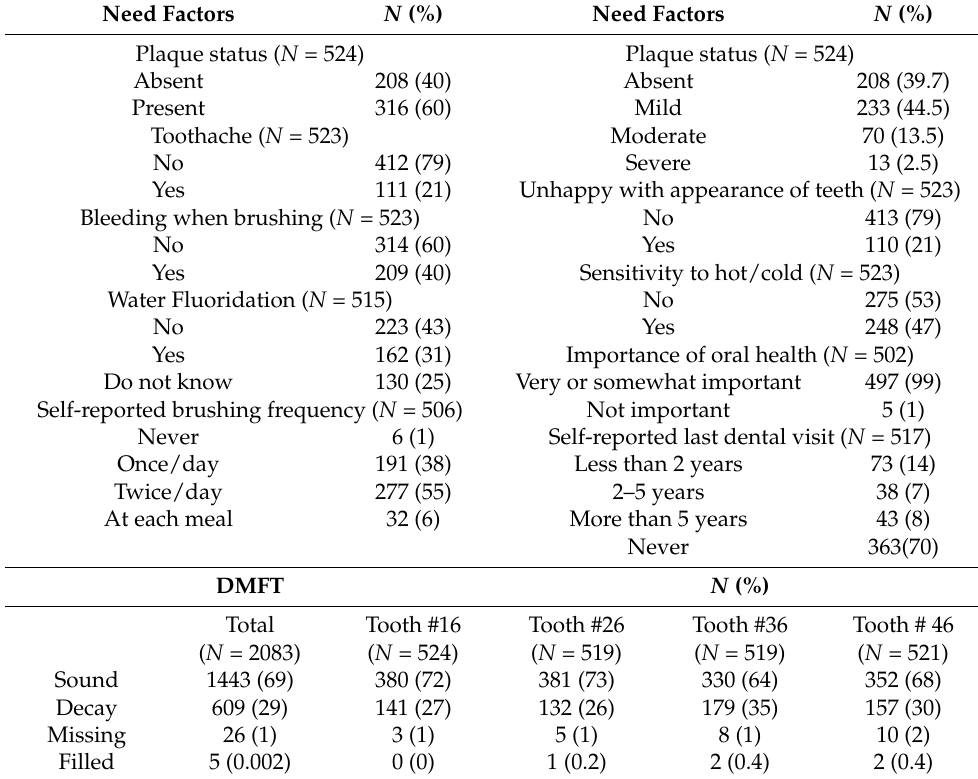
Table 2. Need factors according to the A&N framework of health service utilization ( N = 526).